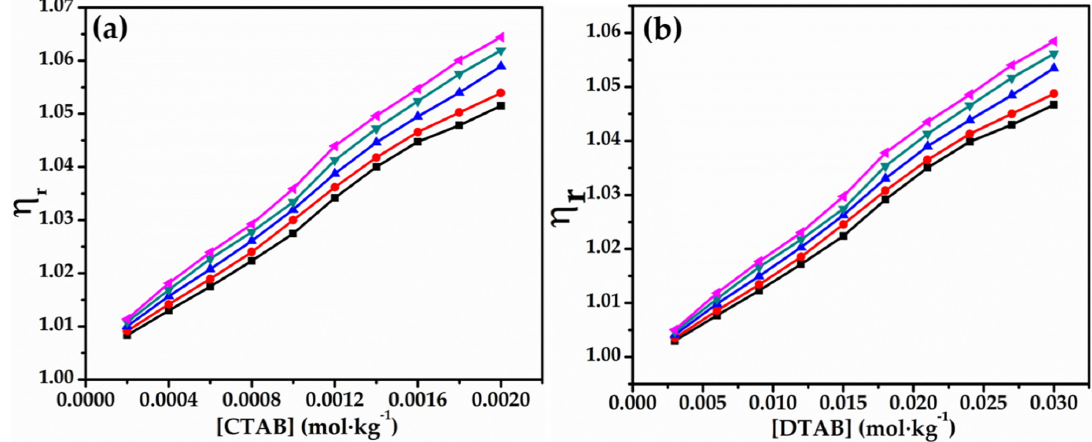
η  Figure 5. Plots of r versus ( a ) [CTAB] and ( b ) in 0.010 mol ∙ kg − 1 aqueous solutions of glycyl dipep- Figure 2. Plots of s versus ( a ) [CTAB] and ( b ) [DTAB] in 0.010 mol∙kg –1 aqueous solution of Figure 5. Plots of η r versus ( a ) [CTAB] and ( b ) in 0.010 mol · kg − 1 aqueous solutions of glycyl dipeptide glycyl dipeptide 293.15 K ( ■ ), 298.15 K (●), 303.15 K ( ▲ ), 308.15 K ( ▼ ) and 313.15 K ( ◆ ). at 293.15 K ( (cid:4) ), 298.15 K ( • ), 303.15 K ( (cid:78) ), 308.15 K ( (cid:72) ) and 313.15 K ( η Table 5. Relative viscosity, r values for CTAB and DTAB in pure water and 0.001, 0.005 and 0.010 Table 3. Apparent molar volume,  V /10 −4 (m 3 ∙mol −1 ) values for CTAB and DTAB in pure water and 0.001, 0.005 and 0.010 mol∙kg −1 aqueous solution of glycyl dipeptide at different temperatures and pressure p = 100